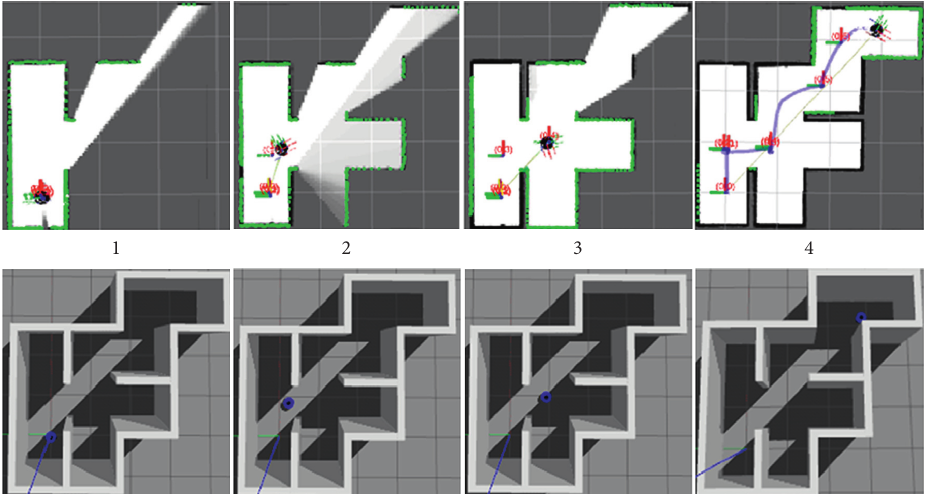
Figure 6: Mapping result of Cartographer (simulation).